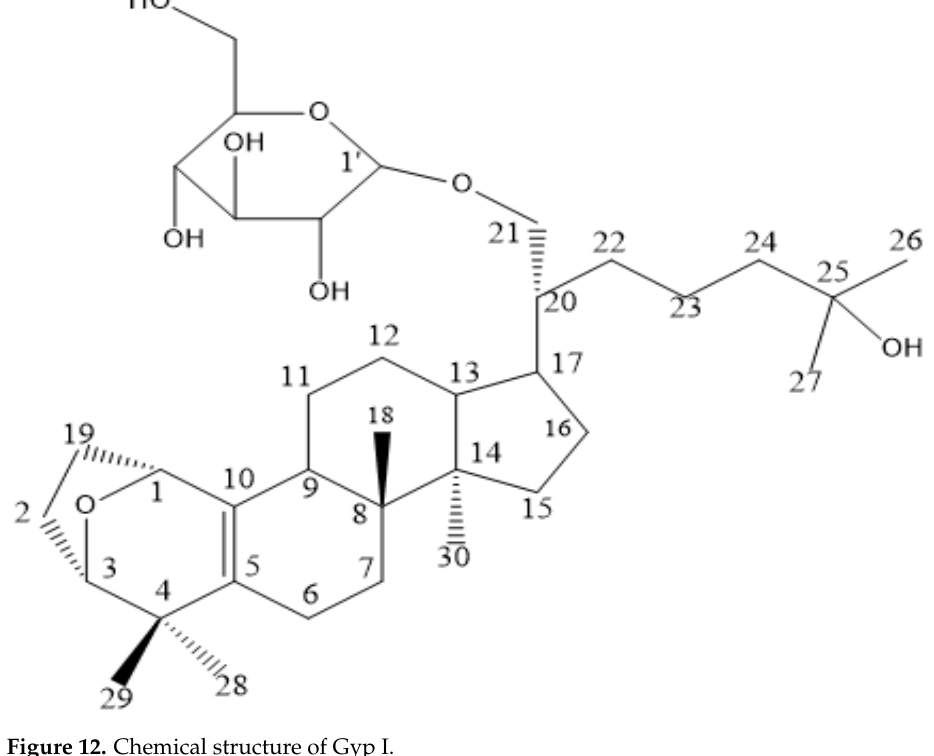
Figure 12. Chemical structure of Gyp I.